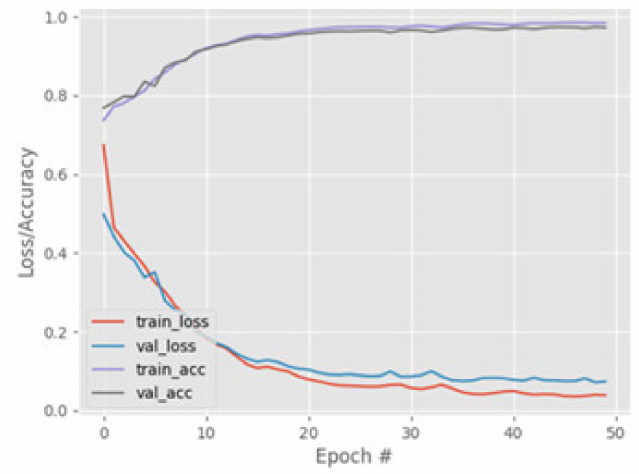
Figure 12. Track of loss / accuracy.